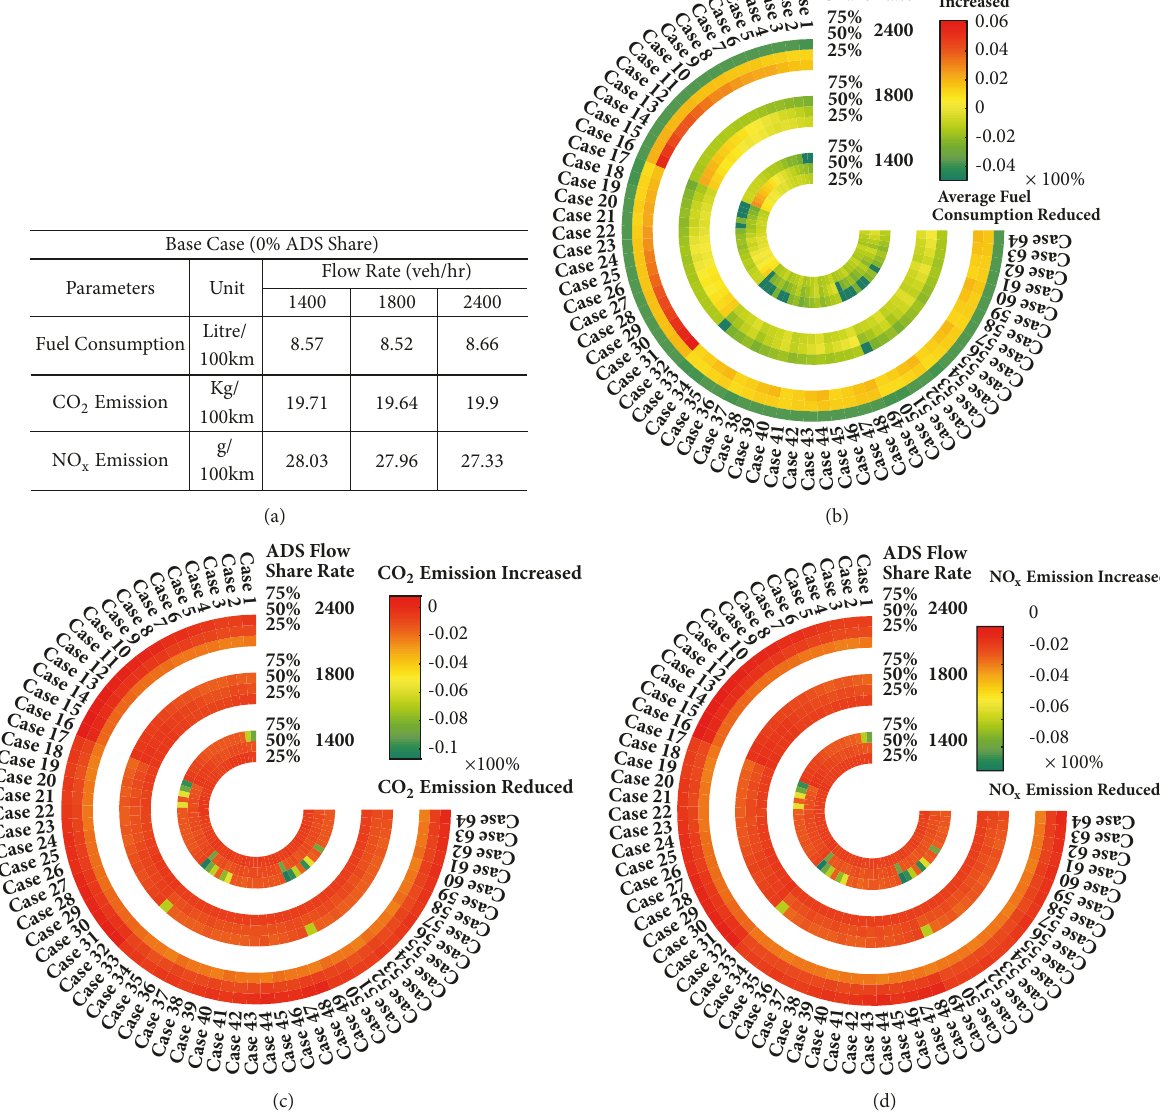
Figure 5: Observed variations of (a) environmental parameters at base case, (b) fuel consumption, (c) CO 2 emission, and (d) NO x emission for varying platoon structures at different traffic